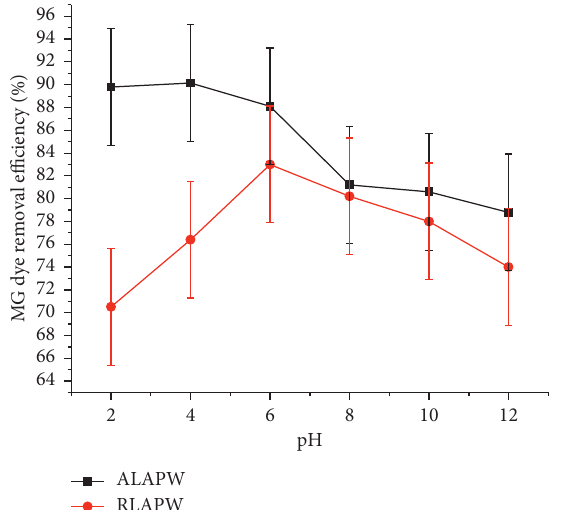
Figure 5: Effect of adsorbent dose on MG dye removal by ALAPW and RLAPW at pH 4 (ALAPW) and pH 6 (RLAPW), initial MG dye concentration 10mg/L, contact time 60min, and temperature (298 K) with agitation speed